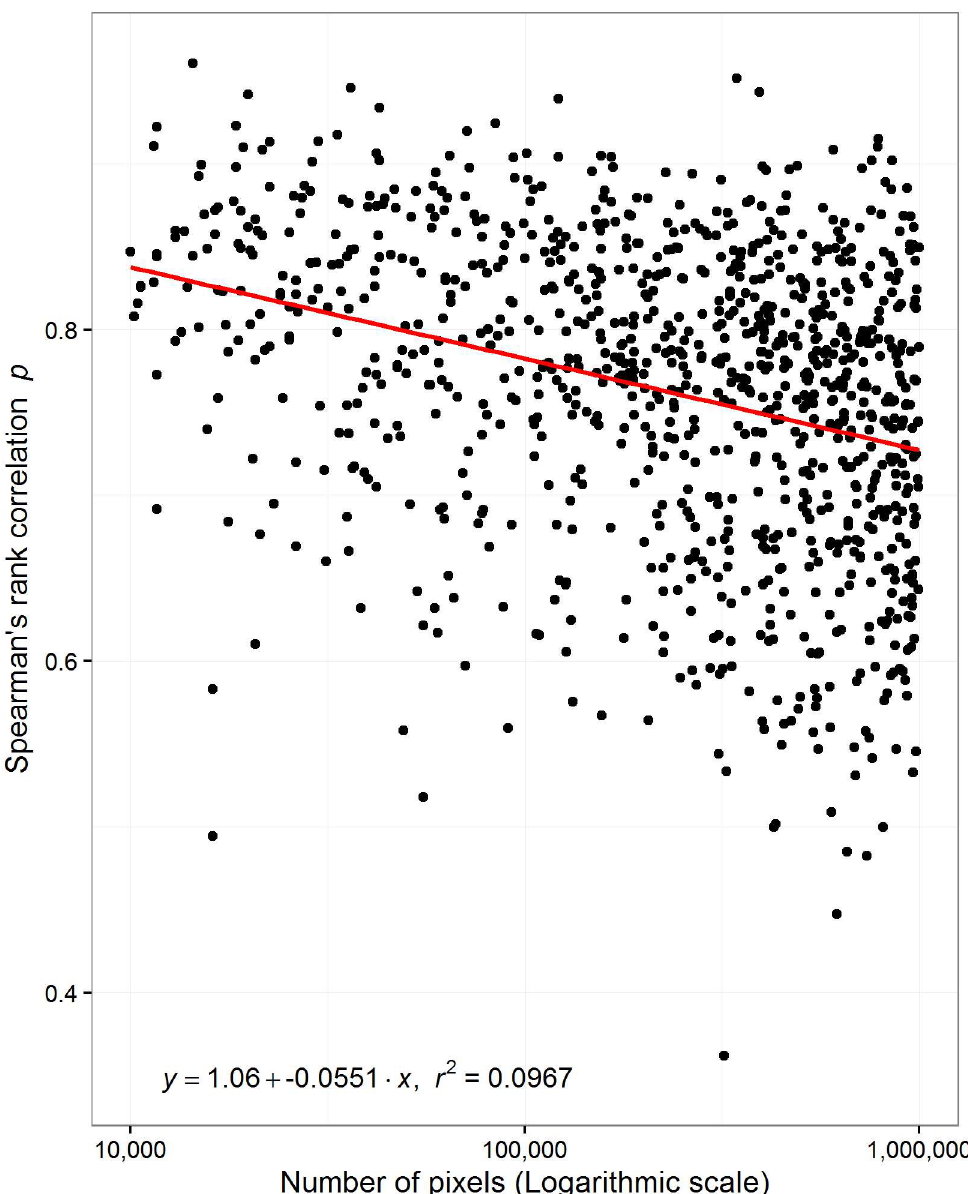
Fig 5. The number of pixels and rank order agreement. The rank agreement ( p ) betweenleast-cost distance in relationwith the log transformed number of pixels representing 1,000 different landscapes with varyingspatial autocorrelation. The x-axis is on a logarithmic scale. Landscapesize (number of pixels) is varied from 10 thousandto 1 million pixels.